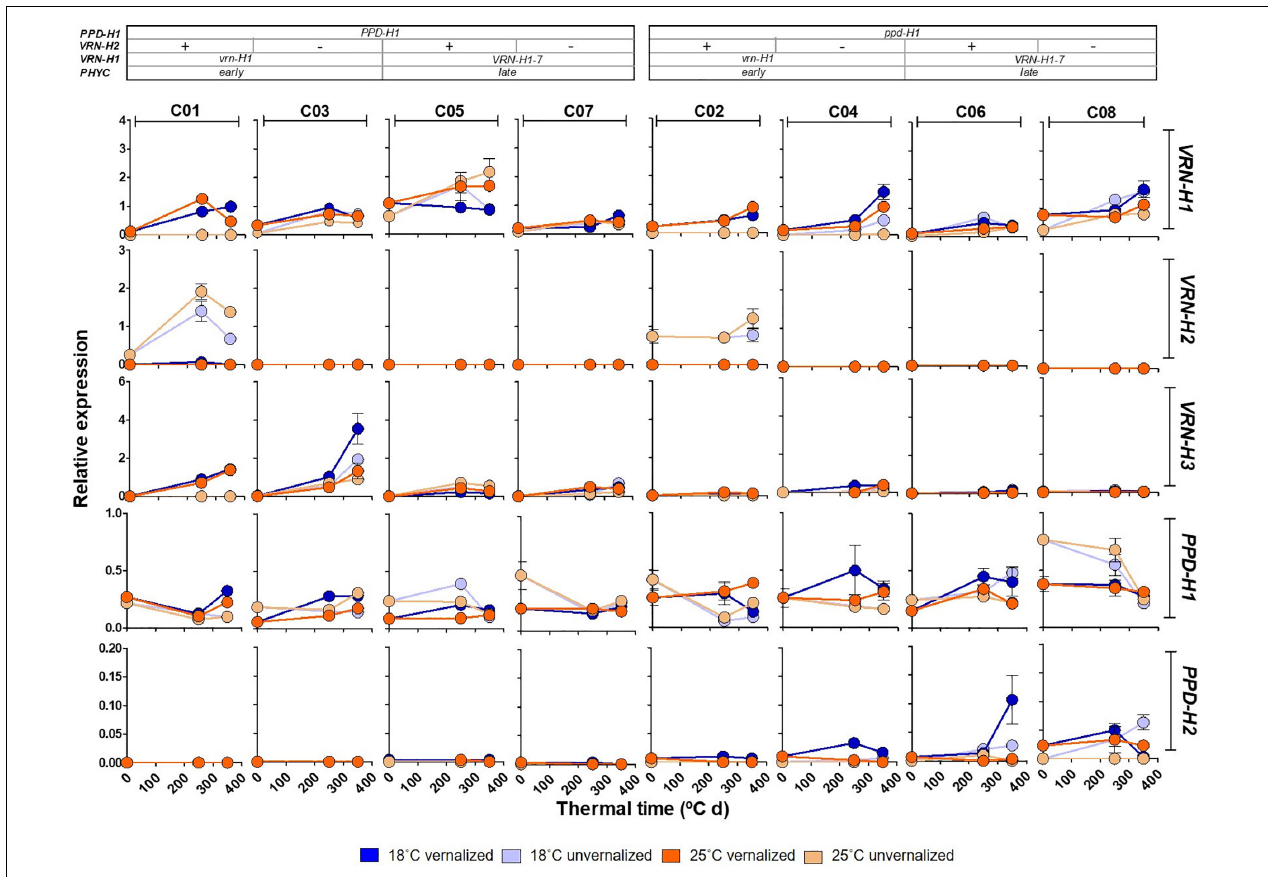
FIGURE 6 | Expression patterns of VRN-H1 , VRN-H2 , VRN-H3 , PPD-H1 and PPD-H2 at three different times (0, 250 and 350 ◦ C d), for the eight barley NILs (C01-C08) subjected to non-vernalized and vernalized conditions and grown at 18 and 25 ◦ C. The genetic composition of the lines is described in the top